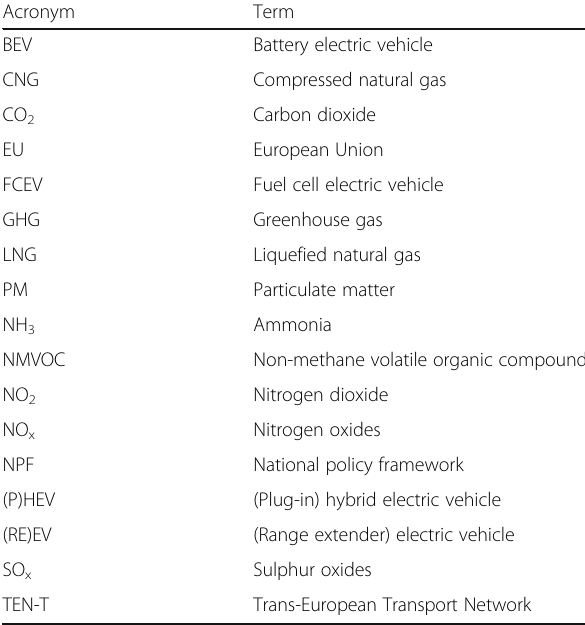
Table 1 Key acronyms used in this